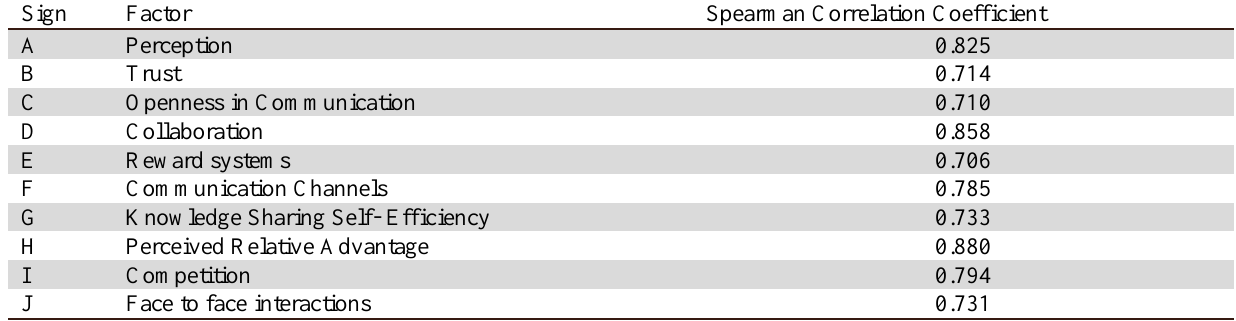
The results of spearman correlation coefficients for each